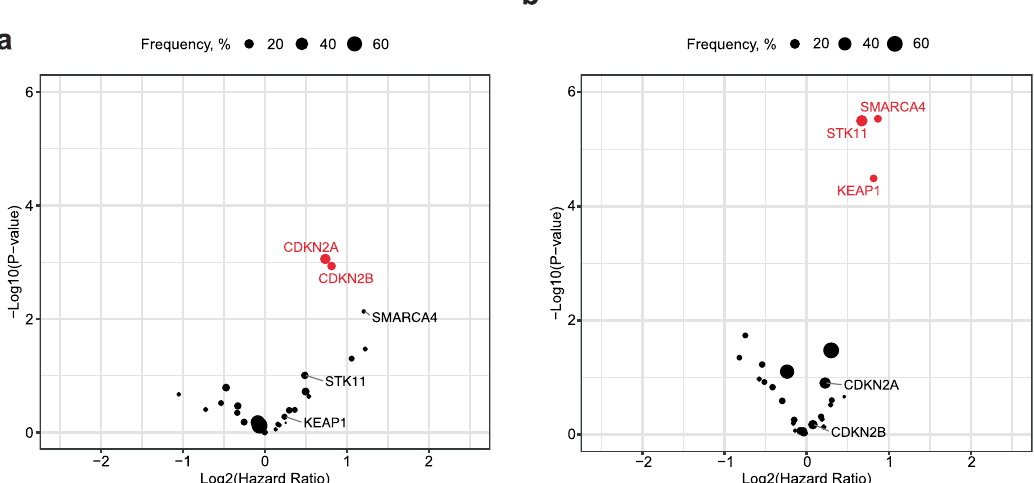
Fig. 2 Genomic determinants of immune checkpoint inhibitor response. Volcano plot representing genes associated with survival in the a mono-IO cohort and b chemo-IO cohort. Signi fi cant genes after Benjamini – Hochberg correction (FDR p -value < 0.05) are colored in